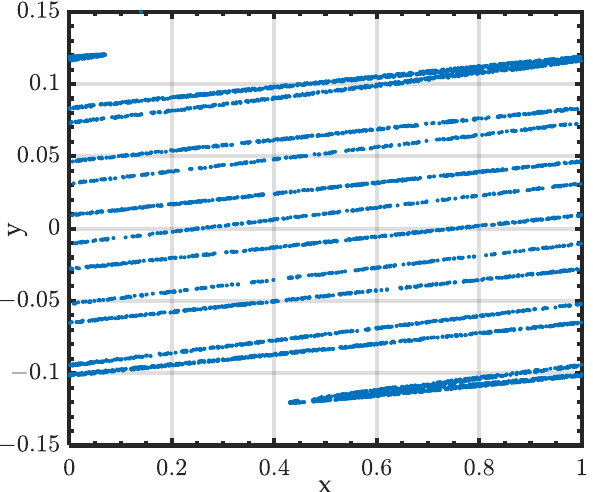
Figure 2. 2-D plot of the Zaslavsky.